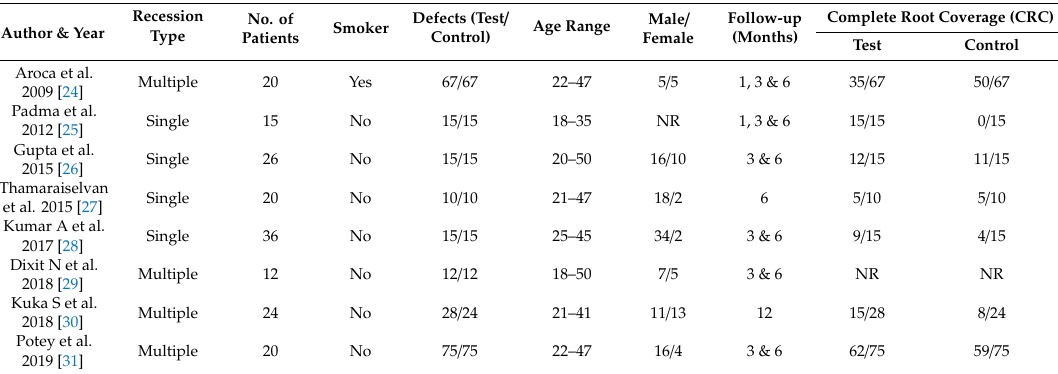
Table 1. General characteristics of included